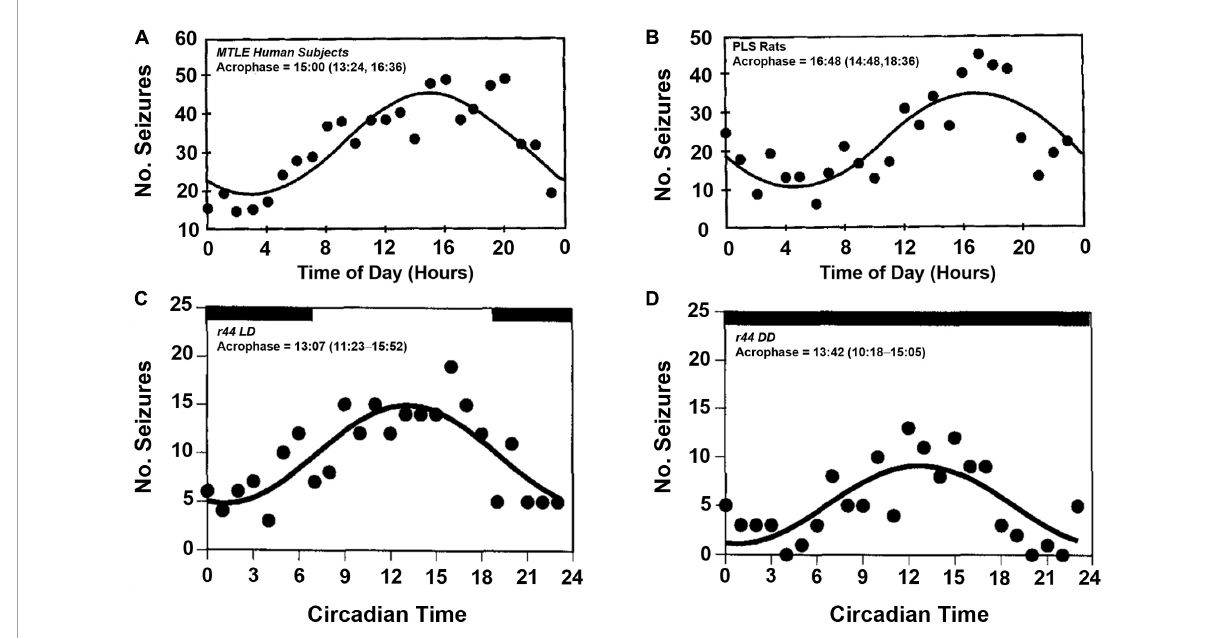
FIGURE2 Temporal distribution of spontaneous seizures in humans and postlimbic status epilepticus rats. Spontaneously occurring seizures in a group of human patients with mesial temporal lobe epilepsy (MTLE, A ) and electrically induced postlimbic status epilepticus (PLS, B ) rats exhibit time of day dependent timing of seizure onset, with most seizures occurring in the afternoon. Example of a single PLS rat (r44) that experienced frequent seizures throughout the day (C) . When housed in constant darkness, the temporal distribution persists, which suggests an underlying, endogenous circadian rhythm regulates time of day dependence of seizure onset (D) . Acrophase denotes the time during peak seizure occurrence calculated by cosinor-non-linear least squares (95% confidence limit). Figures redrawn with permission from John Wiley and Sons. (A,B) From Quigg et al. (1998). (C,D) From Quigg et al.